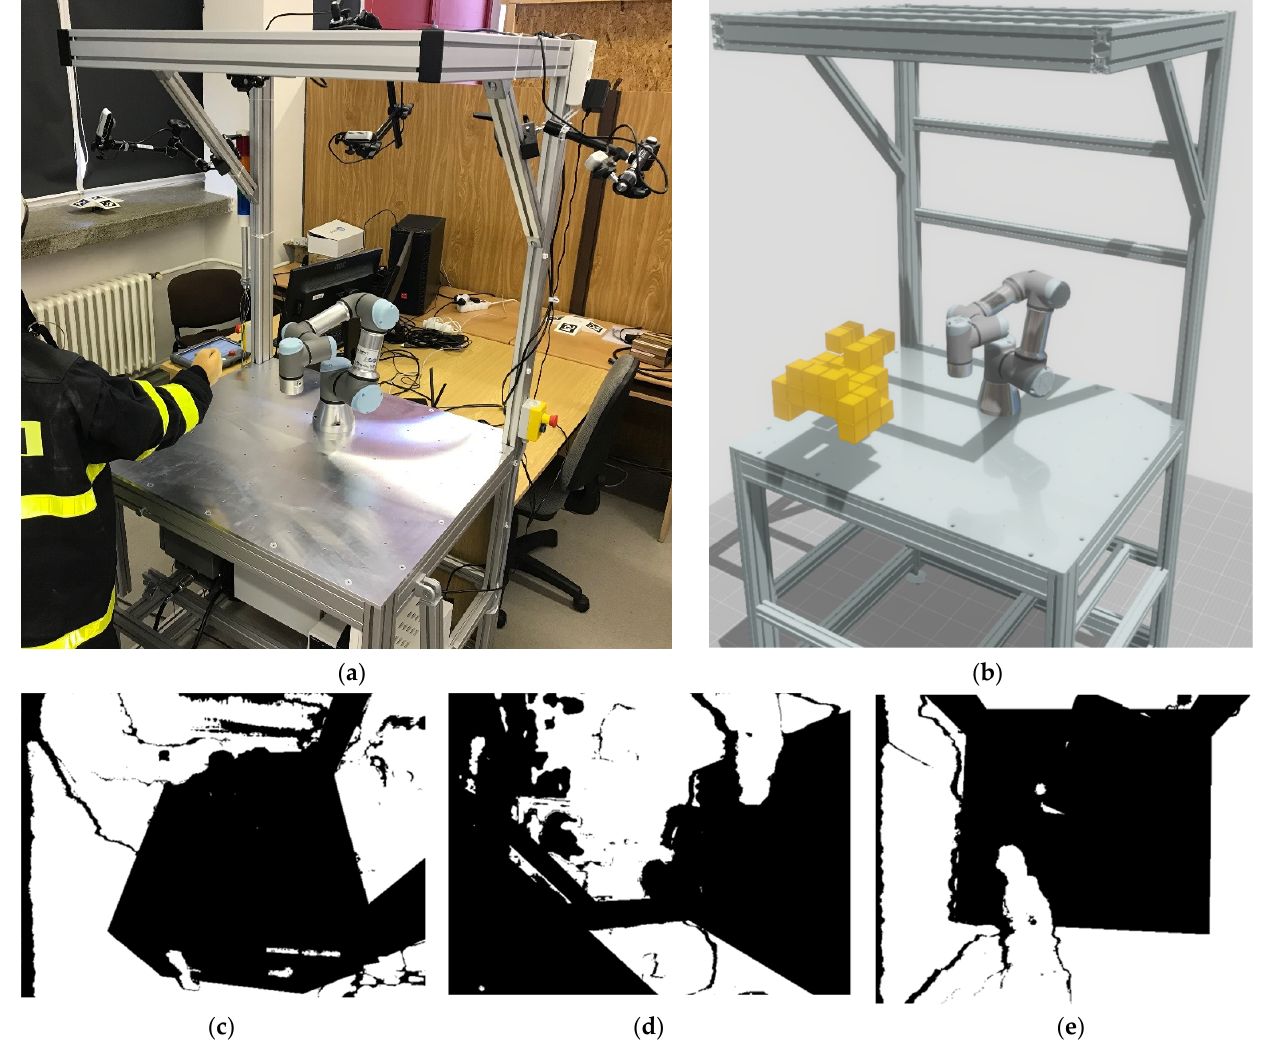
Figure 11. Filtered scene by the distributed method: ( a ) real scenario; ( b ) 3D visualization; ( c – e ) camera bitmask.